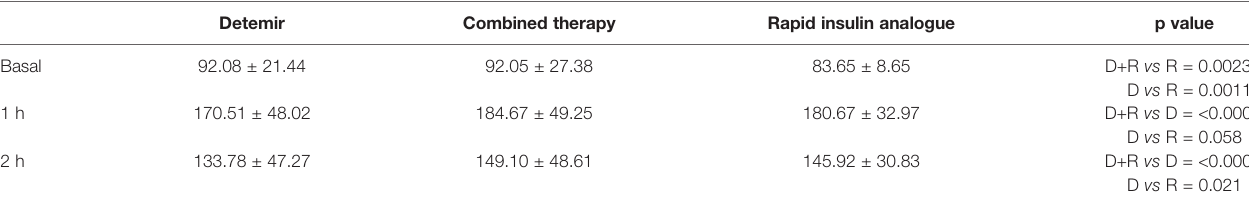
TABLE 5 | OGTT values among women with GDM according to different insulin treatment strategy.